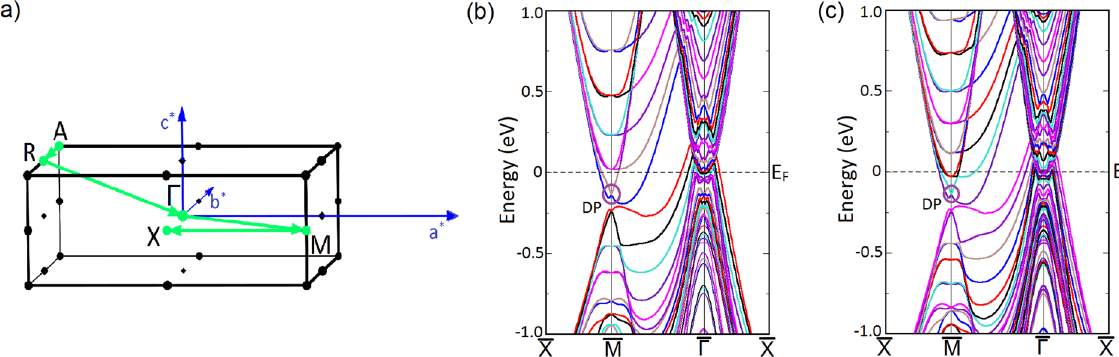
Figure 9. ( a ) The (001)-projected surface Brillouin zone of the LaSb/LaBi multilayer. a * and b * denote the reciprocal lattice vectors. The surface band dispersions for ( b ) 16 layer and ( c ) 20 layer thick slabs along the high symmetry directions ( − − Γ − X M X ) shown in ( a ) calculated using LDA functional and including SO coupling. A Dirac cone appears at the M -point in each case, which indicates the topologically non-trivial nature of the multilayer. The Dirac point is denoted by DP.